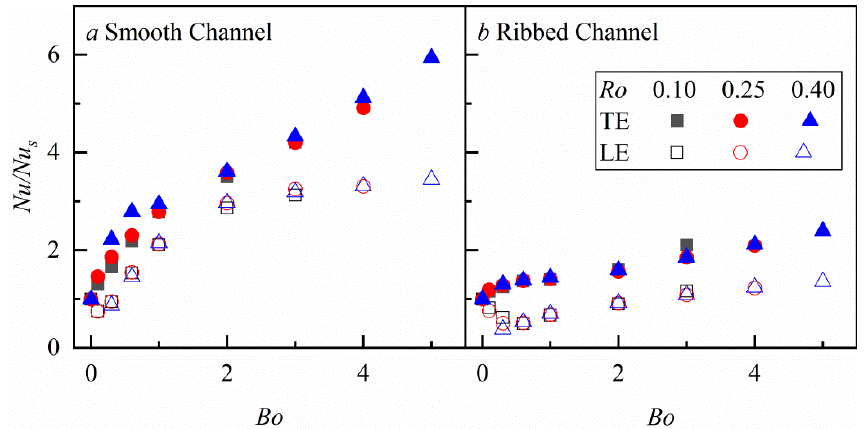
Figure 15. Nu / Nu s – Bo in the first passage (region